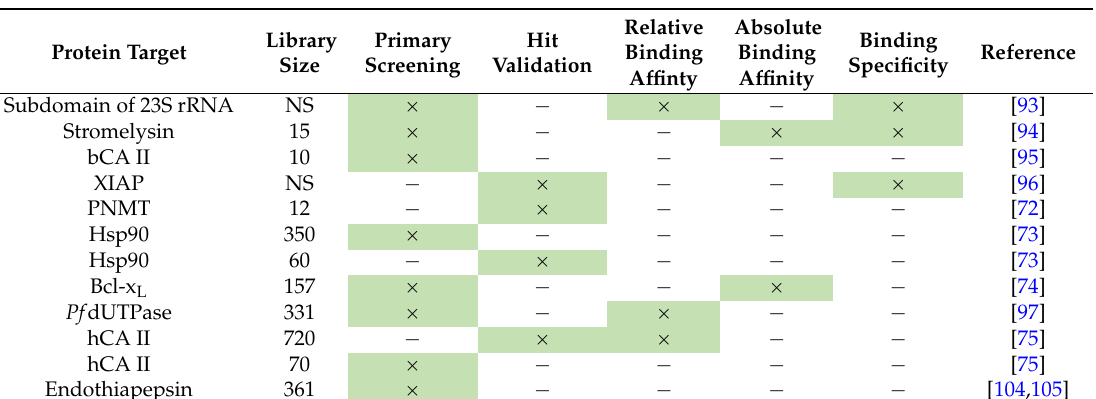
Table 1. Applications of native MS found within FBDD campaigns from the